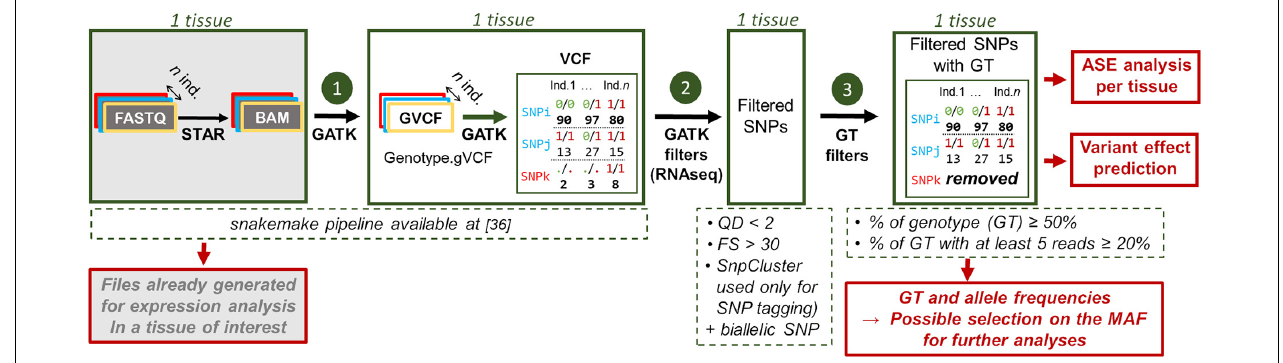
FIGURE 2 | Workflow used to detect SNPs from RNA-seq data. The input files are indicated in gray. GATK filters: QD quality depth, FS: Fisher strand and SnpCluster: 3 or more SNPs in a sliding window of 35 bp. This last criterion was used only for tagging and not for filtering SNPs. For each SNP, are given the genotype (e.g., 0/0) for 3 individuals and under each genotype the associated read number (e.g.,